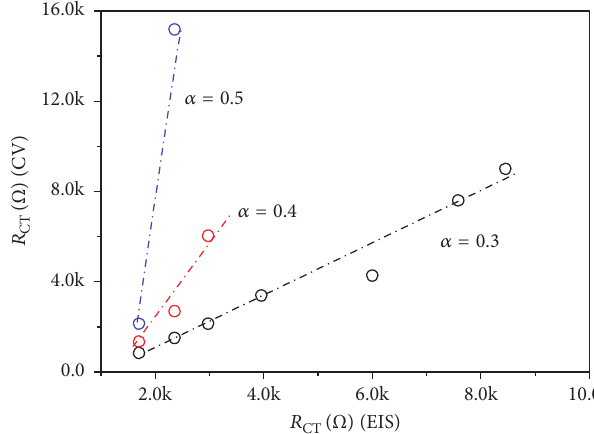
Figure 5: Correlations between the 𝑅 CT resolved from EIS and CV.